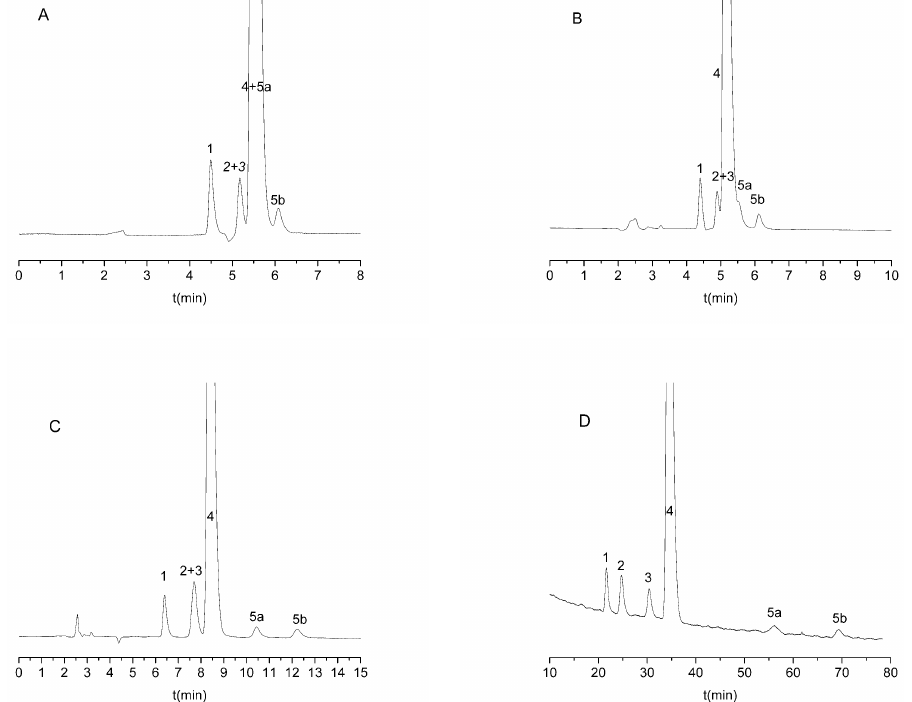
Figure 2. Representative chromatograms on Lux Cellulose-1 column with different acetonitrile water ratio. ( A ) 100% acetonitrile, ( B ) water/acetonitrile 80/20 ( v / v ), ( C ) water/acetonitrile 60/40 ( v / v ), ( D ) water/acetonitrile 40/60 ( v / v ). All mobile phases contain 0.1% diethylamine as basic additive. Other chromatographic parameters: 0.6 mL/min flow rate and 25 °C column temperature. 1: IMP-1; 2: IMP-2; 3: R-citalopram; 4: escitalopram; and 5: IMP-3 (5a is the first eluting enantiomer, while 5b is the second eluting enantiomer of IMP-3).